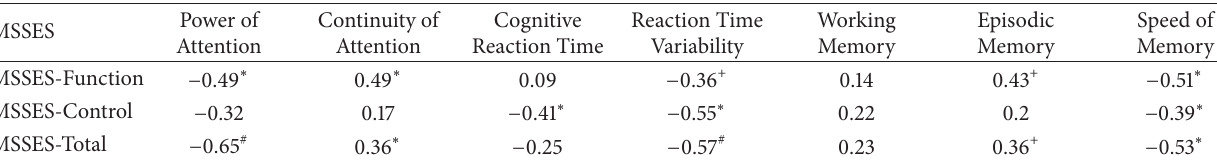
Table 2: Pearson coefficients for the correlations between self-efficacy and cognitive domain scores in persons with CIS and eRRMS ( 𝑁 = 33